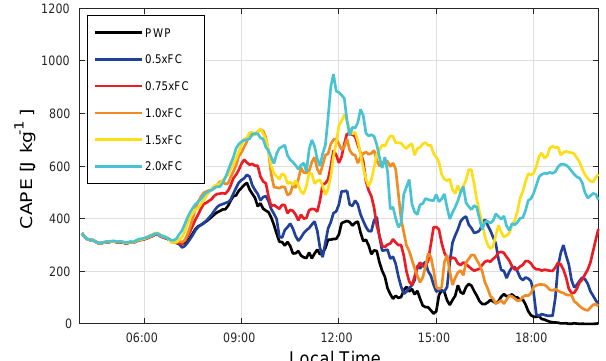
Figure 10. Temporal development of simulated Convective Avail- able Potential Energy (CAPE, [Jkg − 1 ]) within the Nam Co Lake basin for cases PWP, 0.5 × FC, 0.75 × FC, 1.0 × FC, 1.5 × FC and 2.0 × FC on 17 July